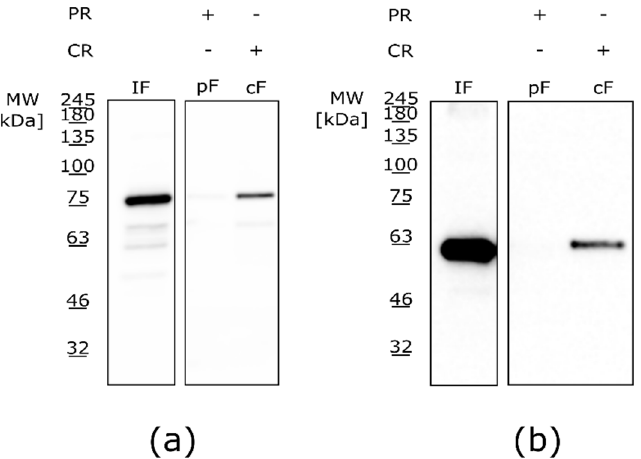
Figure 4. Identification of palmitoylation of overexpressed recombinant MPP1 protein by the Acyl- RAC method. Identification of palmitoylation of ( a ) overexpressed MPP1 protein in HEK-293F ly- sates and ( b ) recombinant MPP1 purified from HEK-293F cells. Both membranes were